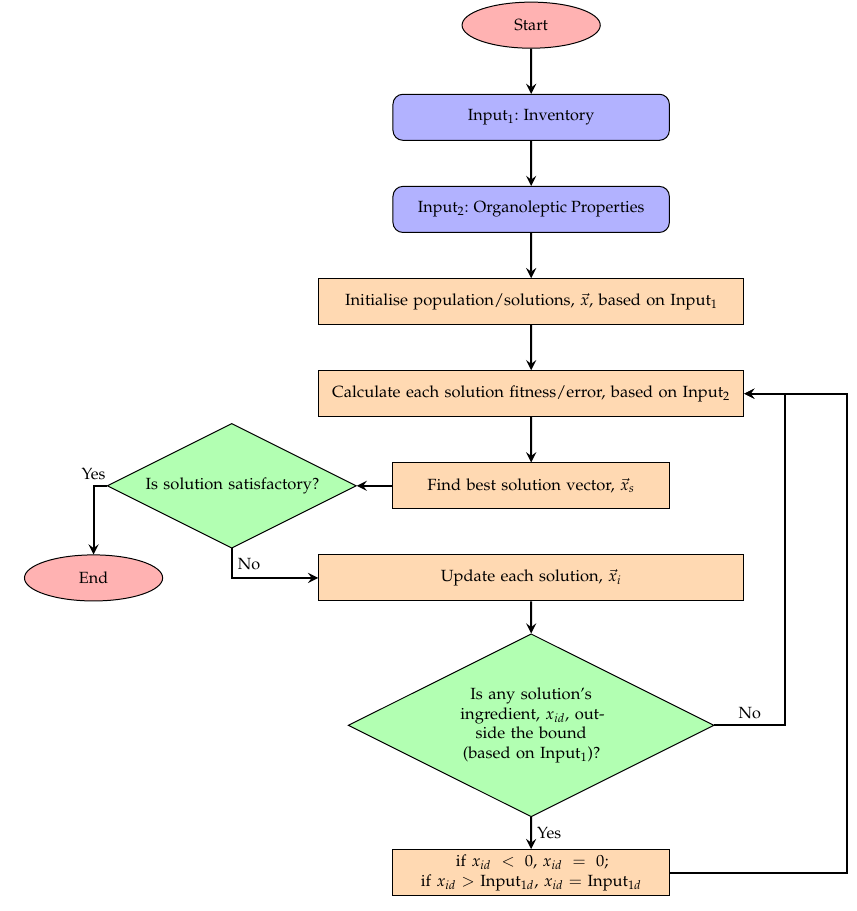
Figure 3. Ingredient